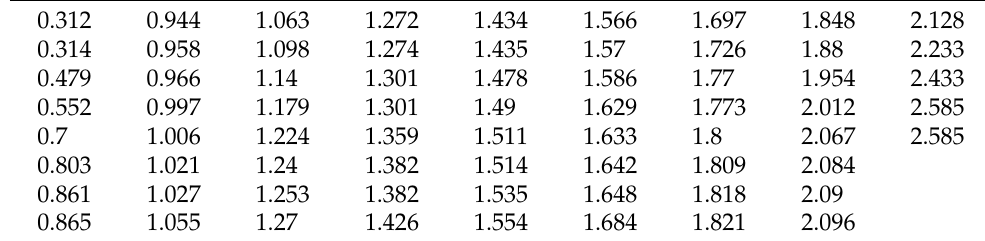
Table 18. Tensile strength (with unit in GPa) for single carbon fibers.